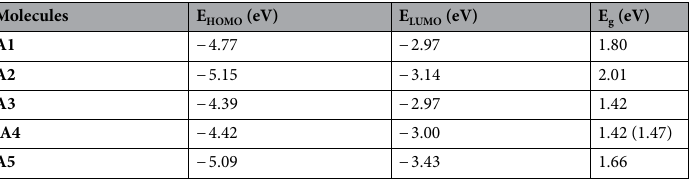
Table1. The calculated orbital and band gap energies of A1 – A5 at B3LYP 6-31 G(d,p) in gas phase. a The value E g for A4 in parenthesis have been calculated by using ΔSCF/B3LYP.